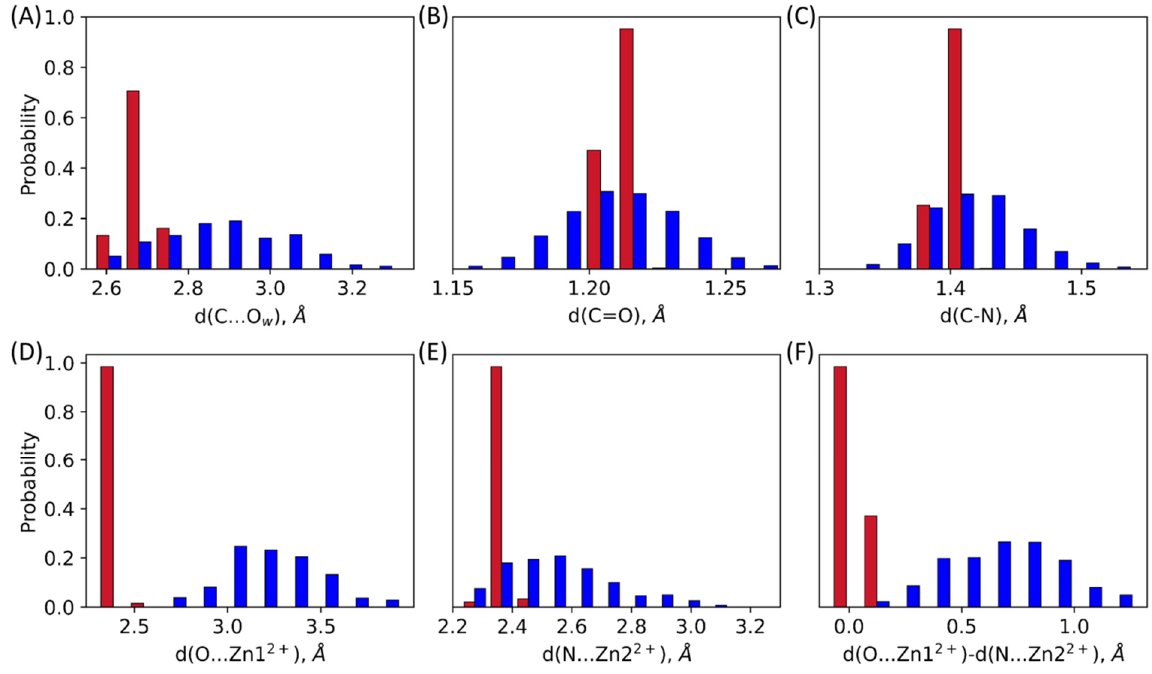
Figure 3. Distributions of interatomic distances in the L1-ES (red) and the NDM-1-ES (blue): ( A ) distance of the nucleophilic attack, d(C…O w ); ( B ) C=O bond length in the carbonyl fragment of the β -lactam ring, d(C=O); ( C ) C-N bond length of the β -lactam ring, d(C-N); ( D ) coordination bond length between the zinc cation and the oxygen atom of the carbonyl group of the substrate, d(Zn1 2+ …O) ( E ) coordination bond length between the zinc cation and the nitrogen atom of the β -lactam ring, d(Zn2 2+ …N) ( F ) difference between Zn1 2+ …O and Zn2 2+ …N coordination bond lengths. All values are from QM/MM MD trajectories of the ES complexes.